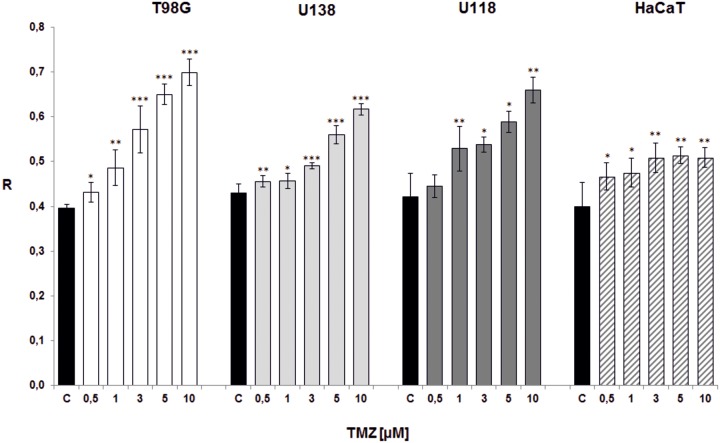
The effect of repetitive doses of TMZ on total DNA methylation.Total amount of m5C in DNA (R) changes during Stupp-mimicking TMZ-therapy. TMZ was administered to glioblastoma (T98G –white bars, U138 –light grey bars, U118 –dark grey bars) and keratinocyte (HaCaT–diagonally striped bars) cell lines at 0.5, 1, 3, 5, 10 μM concentrations for 5 days. Each day cells were washed with PBS and placed in fresh medium with indicated TMZ concentrations. Control (C) cells were treated with DMSO only. The total DNA methylation was estimated after 5th day of treatment. The R values are means from three experiments ±SD. Asterisks indicate a significant difference (*p < 0,05, **p < 0,01, ***p < 0,001) from the control (DMSO) value.